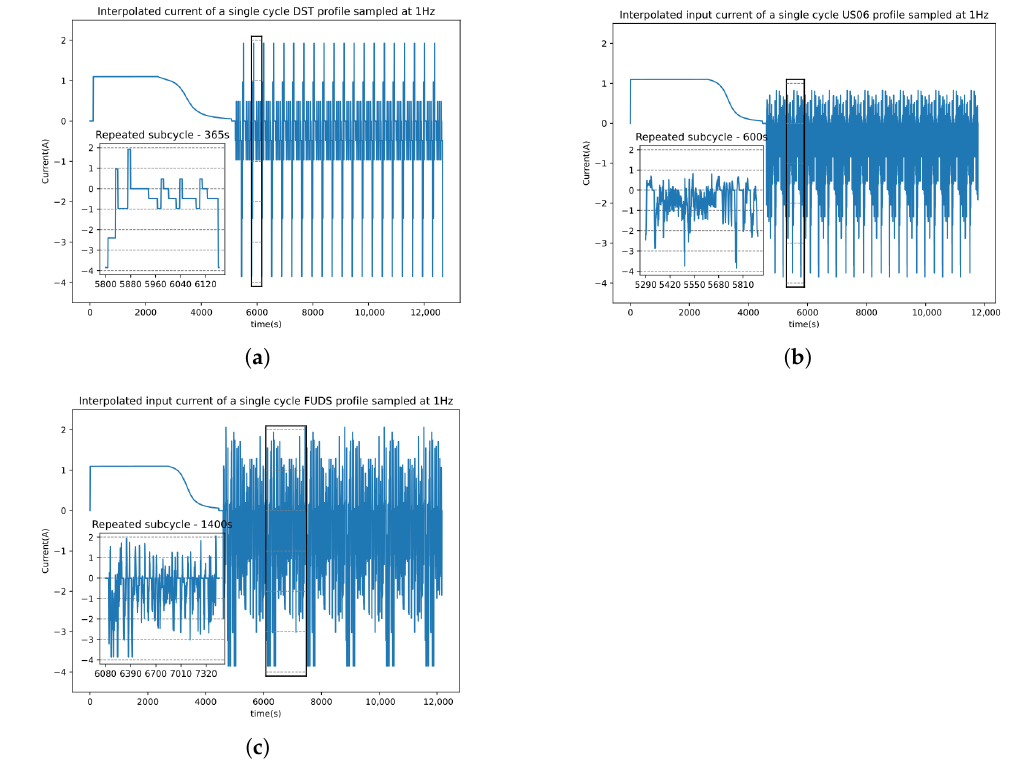
Figure 7. Cell current of three battery testing profiles, emulating a constant-current–constant-voltage charge and regenerative discharge until cells reached top or bottom cutoffs. ( a ) Dynamic stress test (DST) of 20 repeated subcycles; ( b ) highway driving schedule (US06) of 12 repeated subcycles; ( c ) federal urban driving schedule (FUDS) of 6 repeated